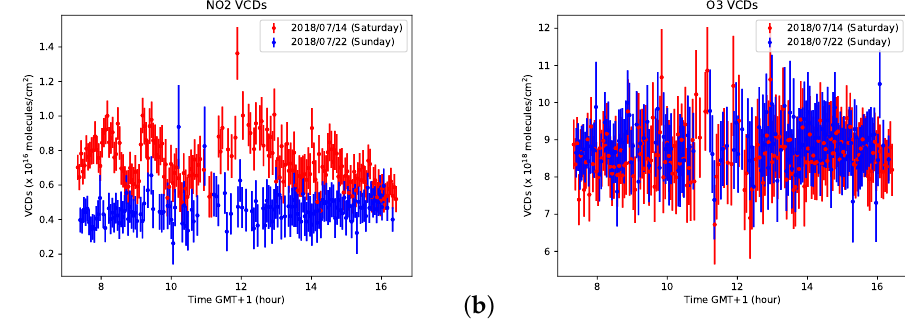
Figure 7. NO 2 ( a ) and O 3 ( b ) VCDs during the days 2018/07/14 (red) and 2018/07/22 (blue). The error bars represent the VCDs random errors derived from the SCDs fitted by